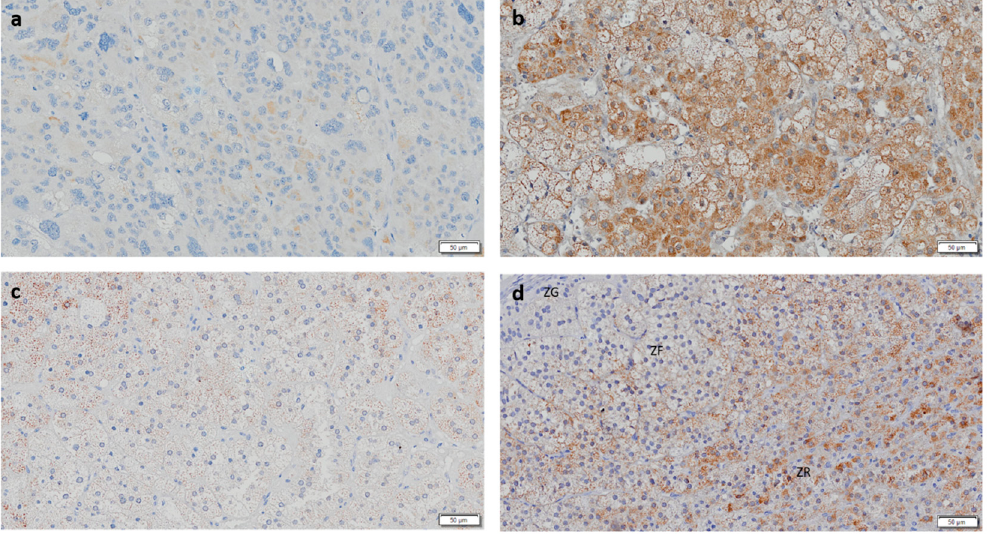
Figure 2. Immunohistochemistry staining for CYP11B1 (Scale = 50 µ m). ( a ) Adrenocortical carcinoma, ( b ) adrenocortical adenoma with Cushing’s syndrome, ( c ) non-functioning adrenocortical adenoma, and ( d ) normal adrenal gland. ZG – zona glomerulosa; ZF – zona fasciculata; ZR – Zona reticularis.